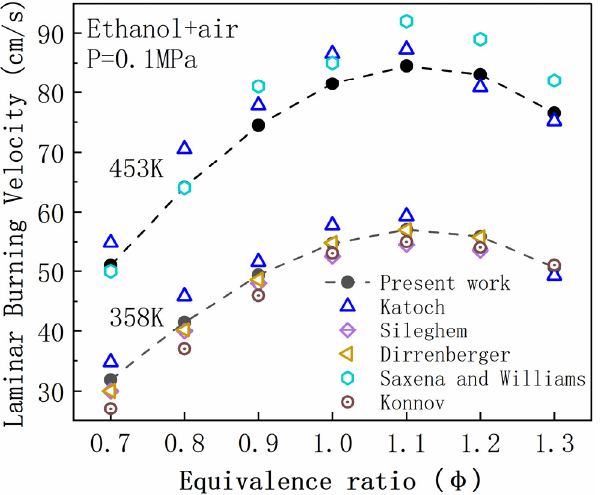
Figure 3. LBV of ethanol–air flame obtained in the literature and in this study: working conditions at 0.1 MPa and 358/453 K.